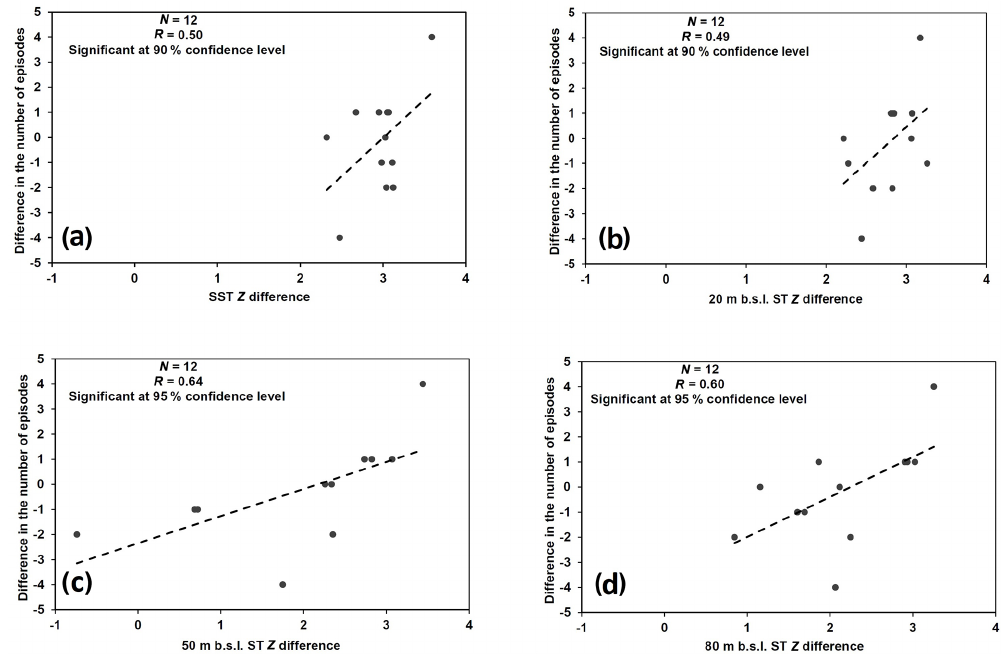
Figure 11. Scatter plot of the 10d relationship between the differences in the number of episodes (1984–2016 minus 1951–1983) and ST Z differences for two 5-year subperiods (2013–2017 minus 1973–1977) at surface (a) , 20mb.s.l. (b) , 50mb.s.l. (c) and 80mb.s.l. (d) during the wet season (from September to November) and December (a dashed line indicates the linear regression). Table 3. 10d period ST standardised value ( Z ) differences for two 5-year subperiods (2013–2017 minus 1973–1977) at surface, 20, 50 and 80mb.s.l. during the wet season (from September to November) and December.